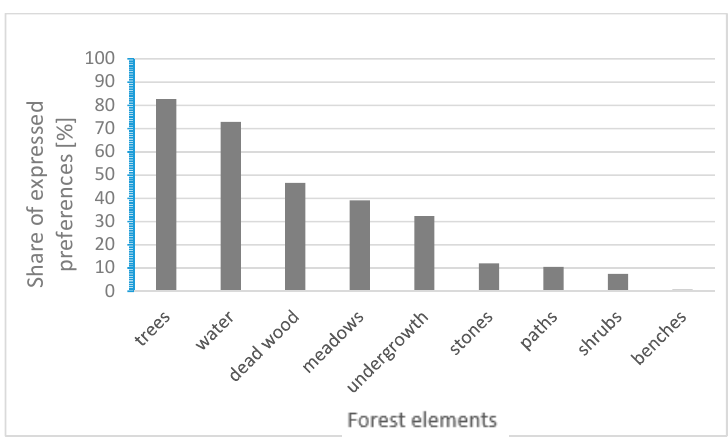
Figure 2. The availability preference for the chosen forest elements.